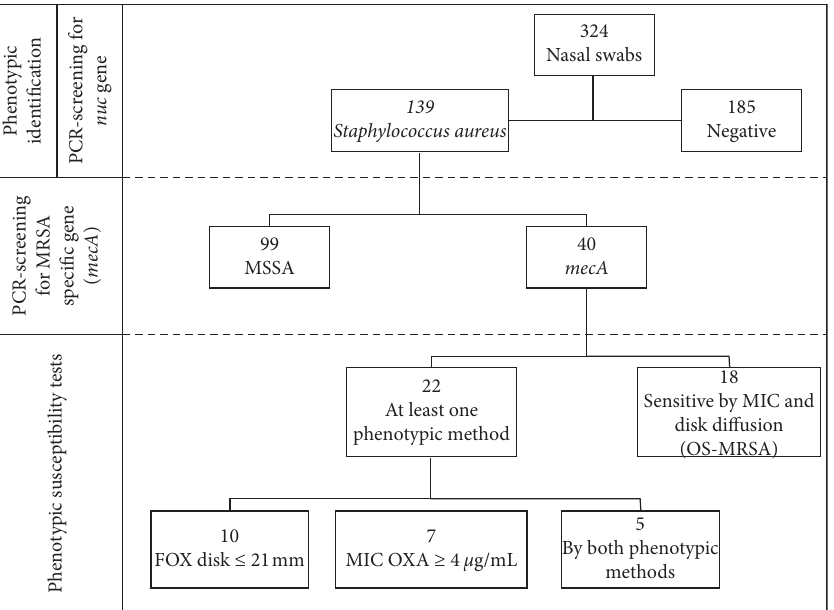
Figure 1: Flowchart of the procedures and the results for nasal swabs obtained from healthcare workers and students attending the University Hospital of Londrina from December 2017 to May 2018. PCR: polymerase-chain reaction; MSSA: methicillin-susceptible Staphylococcus aureus ; MRSA: methicillin-resistant S. aureus ; MIC: minimal inhibitory concentration; OS-MRSA: mec A-positive oxacillin- susceptible S. aureus ; FOX: cefoxitin; OXA: oxacillin. Table 1: Potential risk factors for nasal carriage with Staphylococcus aureus and methicillin-resistant S. aureus ( mec A-positive) isolates among healthcare workers and students attending the University Hospital of Londrina from December 2017 to May 2018.